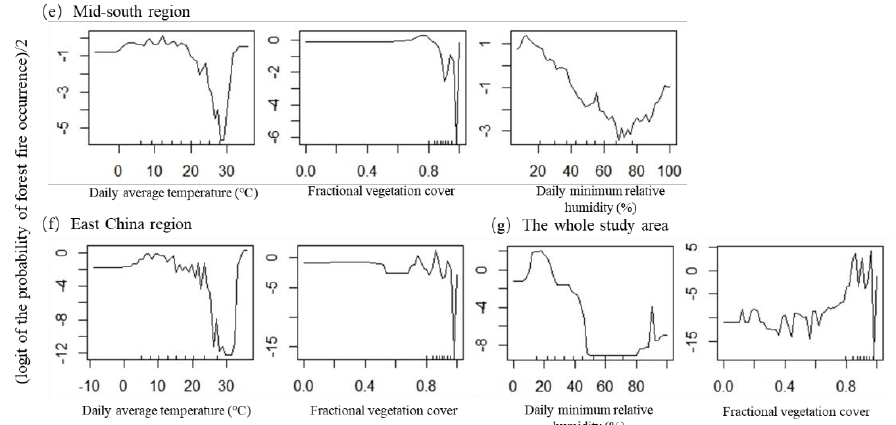
Figure 4. Partial dependence plots of each forest fire driving in six geographical regions and the whole study